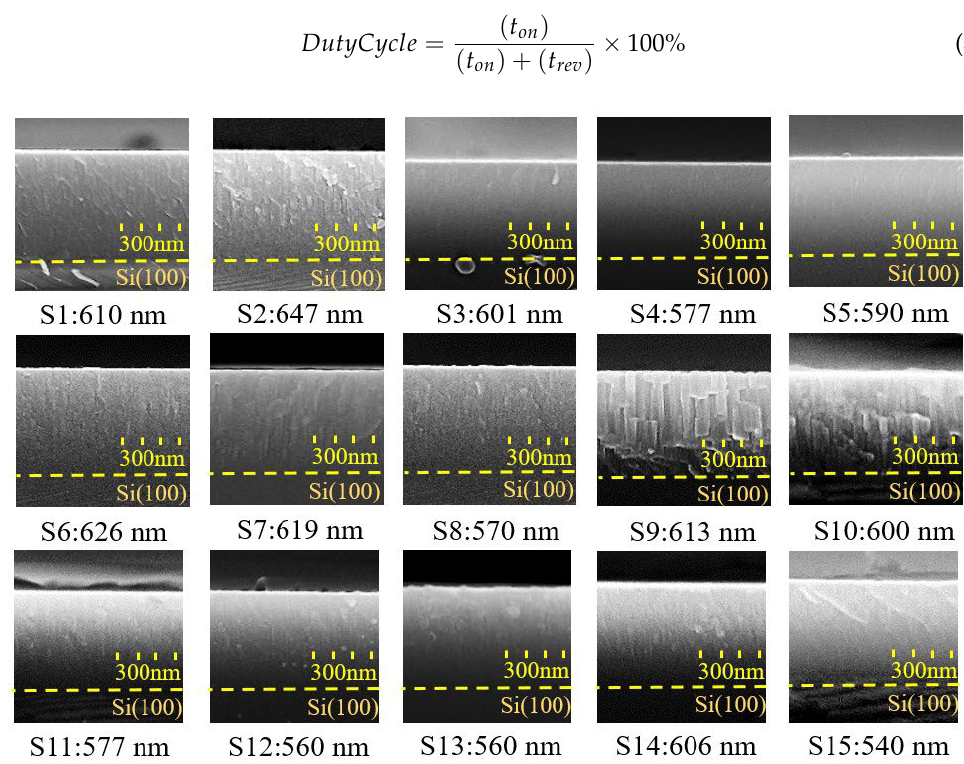
Figure 8. The cross-sectional micrographs of FE-SEM on AlN thin films (S1–S15 in film thickness).